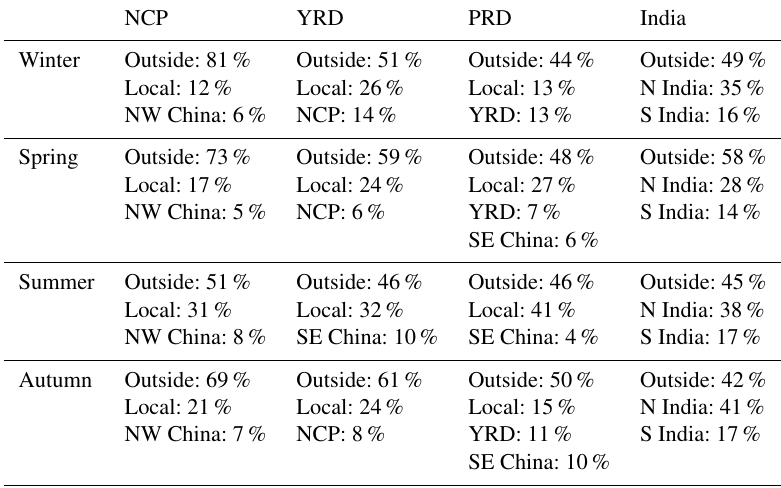
Table 5. Long-range transport, local, and regional source contributions for seasonal mean O 3 for different regions.